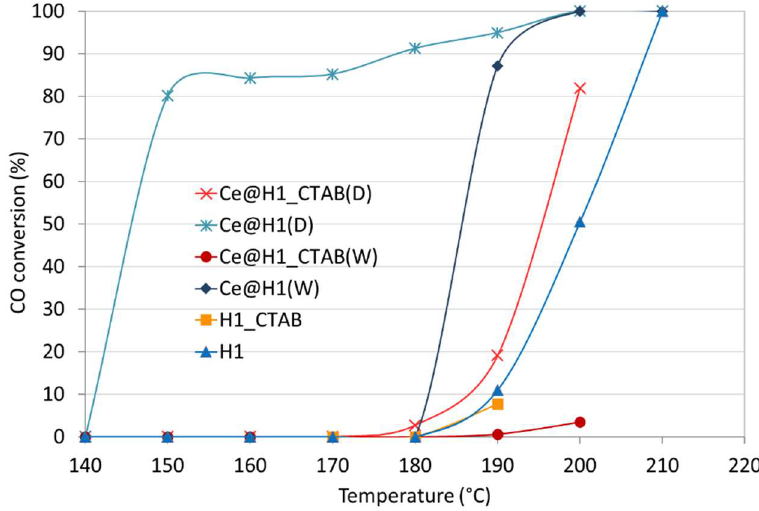
Figure 11. CO conversion versus temperature over HKUST-1 and Ce@HKUST-1 Figure 11 . CO conversion versus temperature over HKUST-1 and Ce@HKUST-1 catalysts.